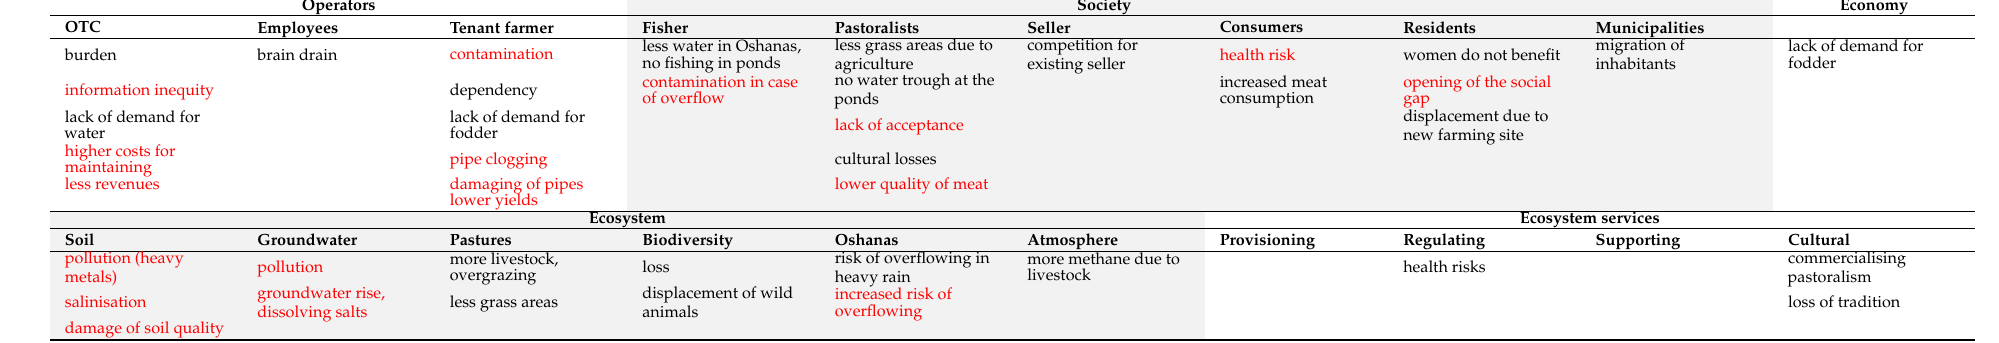
Table 3. Unintended impacts of the upgrading process related to good (black) and poor (red) operation, allocated to spheres of influences.